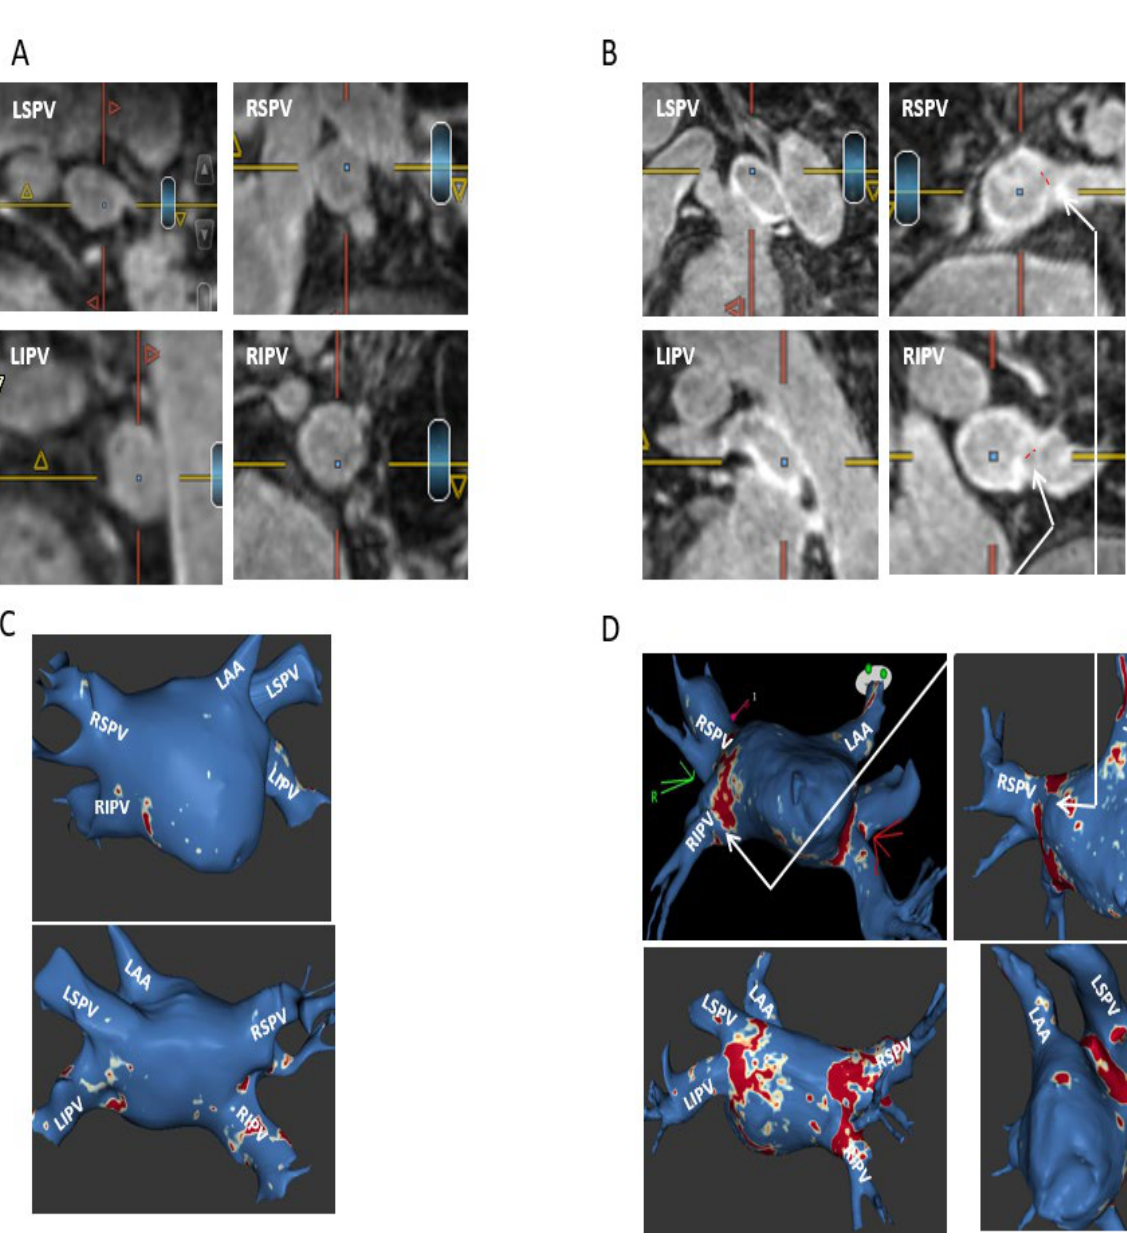
Figure 2. A typical patient with cryoballoon-induced complete/sub-complete circumferential fibrosis in all PVs. Shown are pre-ablation ( A ) and post-ablation ( B ) cross-sectional short-axis views of the four PVs revealing minimal PV ostial fibrosis at baseline, while at post AF ablation, there is a complete circumferential fibrosis around both left PVs and sub-complete circumferential fibrosis around both right PVs, with minimal gaps in the anterior segments of both veins (red dottedlines). ( C , D ) Corresponding ADAS 3D LGE model images pre ( C ) and post ( D ) cryoballoon AF ablation showing minimal LA fibrosis at baseline, post-ablation complete circumferential fibrosis around both left PVs without any gaps, and sub-complete circumferential fibrosis around both right PVs due to minimal gaps at their anterior segments, corresponding with the original images analyses. The post-ablation fibrotic areas on ADAS are colored red, while PV gaps are seen as blue color. The arrows show the matching of the minor PV gaps around both right PVs between the original MRI cross-sectional views and the ADAS model images.